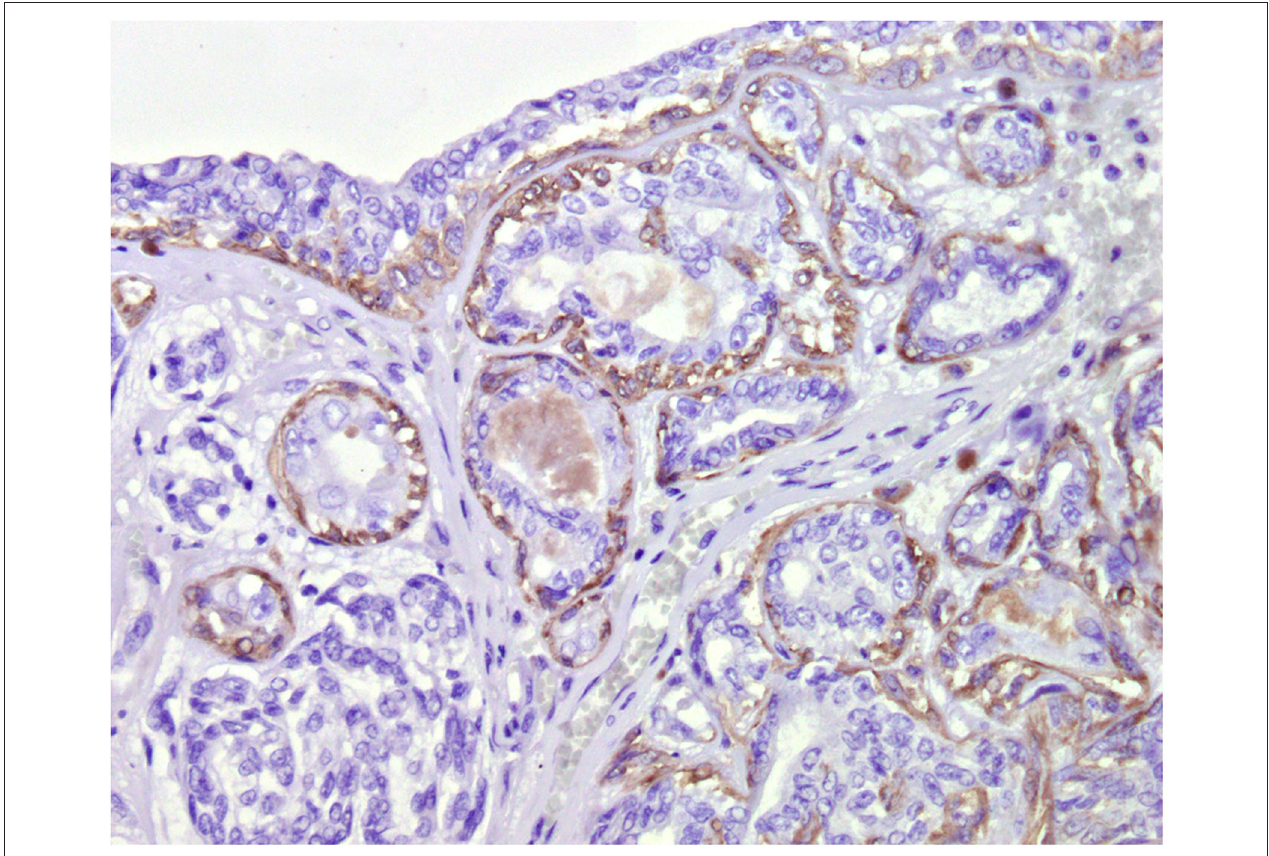
FIGURE 4 | Tubular carcinoma, mammary gland, dog. Immunohistochemical cytoplasmic staining of calponin. Myoepithelial cells are